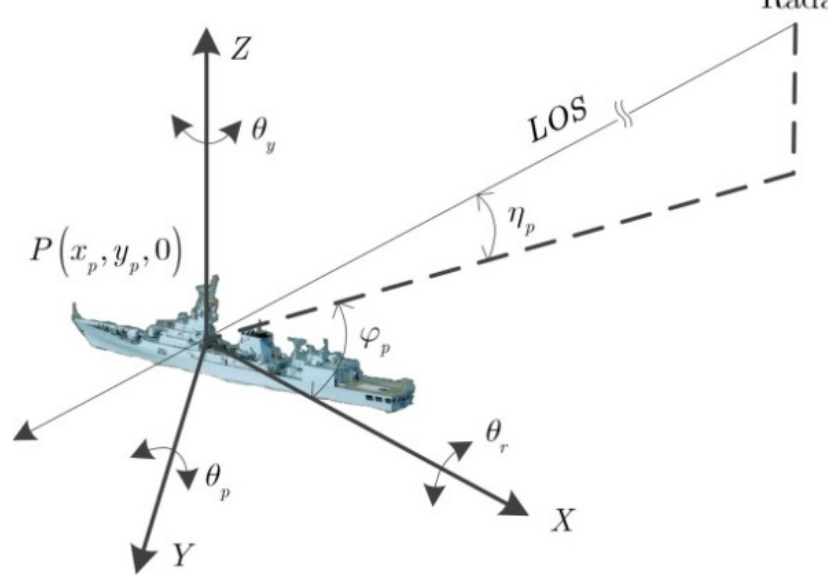
Figure 1. Geometry model for ship target with complex motion.